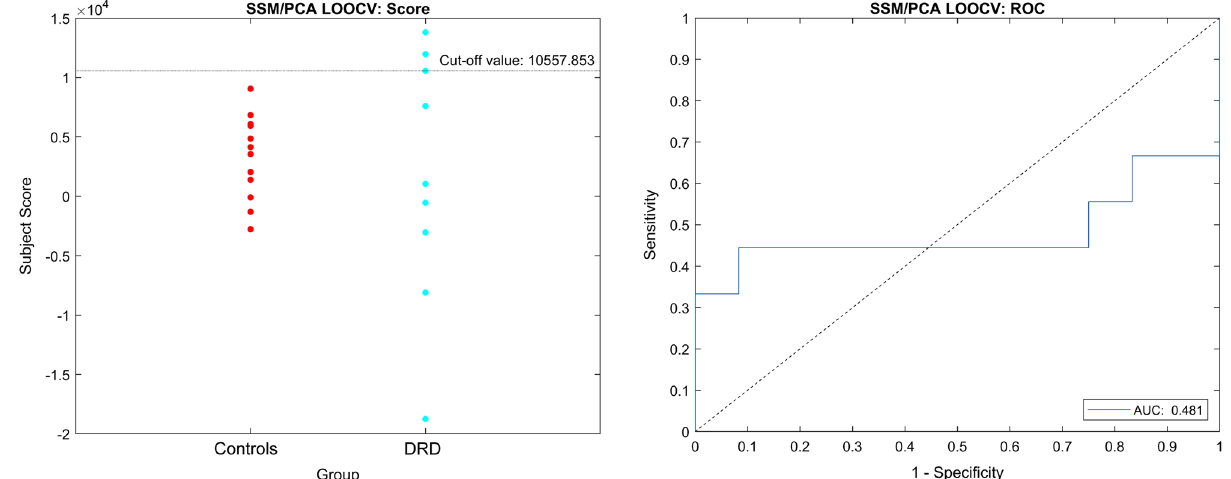
Figure 3. SSM/PCA analysis subject score and relative operating characteristic curve. Left: subject scores for the disease related covariate pattern after a leave-one-out cross-validation (LOOCV). Right: relative operating characteristic (ROC) curve for the disease-related covariate pattern after LOOCV with an area under the curve (AUC) of 0.5.